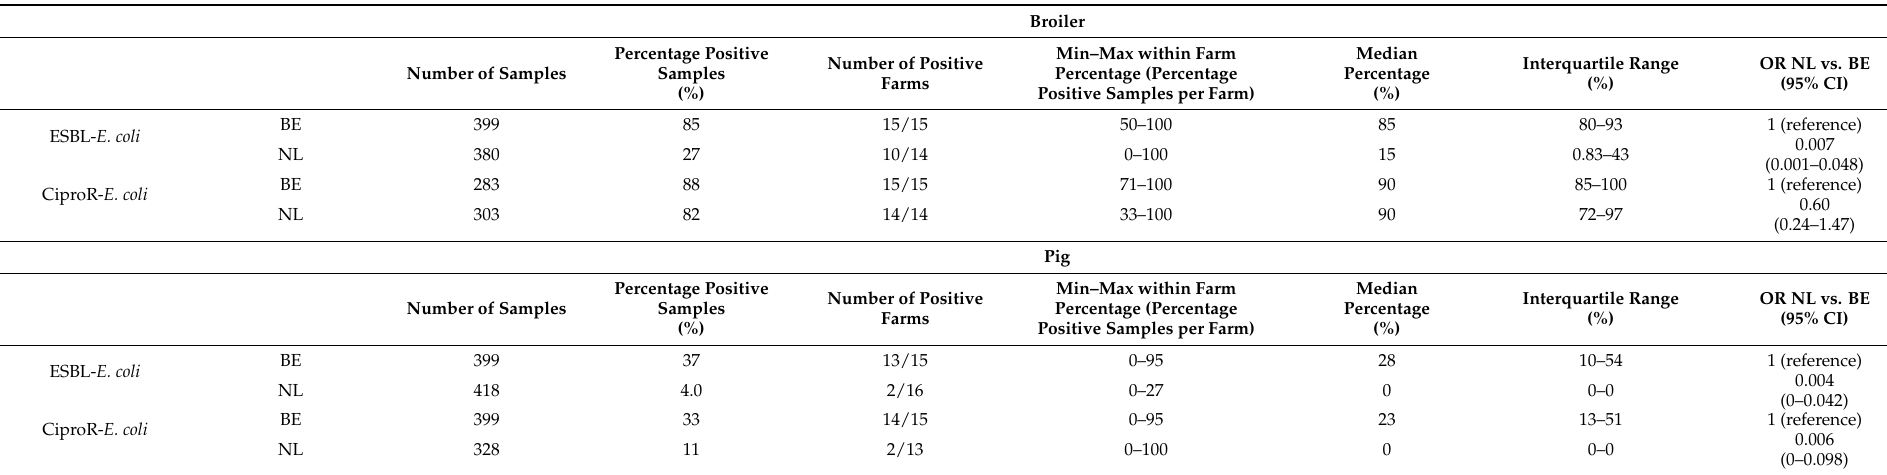
Table 1. Distribution of farm level percentage of positive samples for ESBL- E. coli and CiproR- E. coli in Belgian and Dutch broiler and pig farms with estimated odds ratio for a positive sample.